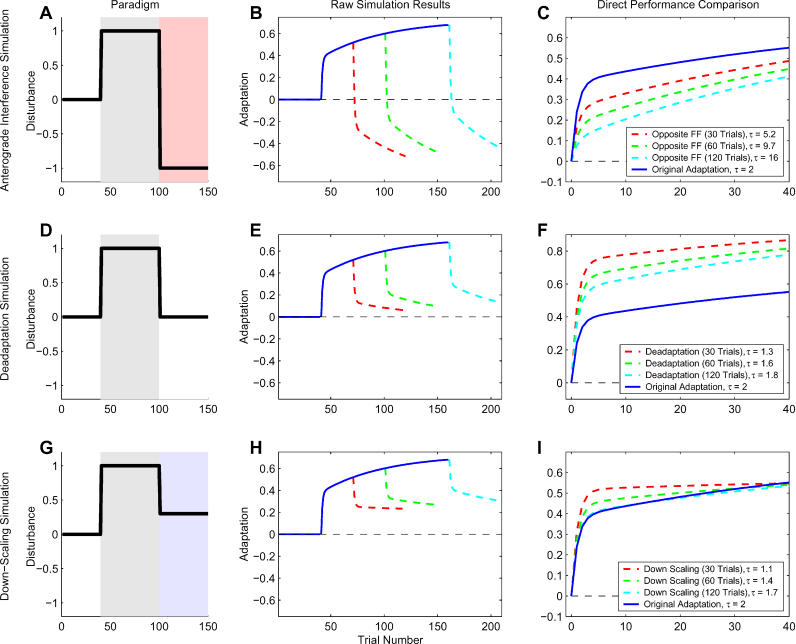
Simulations of Motor Adaptation with the Multi-Rate Model Explain a Variety of Previously Reported Results, Including Rapid Unlearning and Rapid Downscaling(A–C) Anterograde interference.(D–F) Rapid unlearning.(G–I) Rapid downscaling.First column (A, D, and G): experiment paradigms. Second column (B, E, and H): Raw simulation results. Blue: initial adaptation. Red, green, and cyan: secondary adaptation after 30, 60, or 120 trials of the initial adaptation, respectively. Third column (C, F, and I): Comparison of adaptation rates for initial and secondary adaptations. Here the learning curves have been shifted so that they all begin at zero and scaled so that the desired performance level is one. In the anterograde interference paradigm (A–C), the multi-rate model predicts that learning the opposite force field proceeds with a slower time constant than initial learning; furthermore, this time constant gets even slower when number of trials in the initial learning block is increased. The multi-rate model predicts that unlearning proceeds with a faster time constant than initial learning (E–F) and the time constant for downscaling is faster still (H–I); however, the time constant for unlearning or downscaling returns to baseline when the number of trials in the initial learning block is increased. In summary, the multi-rate model simultaneously explains the effects of anterograde interference, rapid unlearning, and rapid downscaling. Furthermore this model predicts that anterograde interference will get stronger as the length of the initial adaptation period increases, but that rapid unlearning and rapid downscaling will get weaker as the length of the initial adaptation period increases.